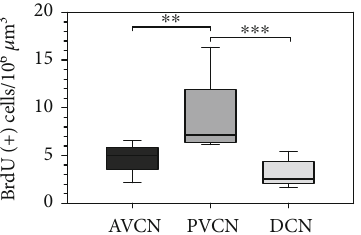
Figure 6: The whole-mount organ cultures of CN subnuclei showed a di ff erent mitotic capacity in the BrdU assay. A positive BrdU staining of individual cells was demonstrated in all examined preparations. The AVCN had an average of 4 : 7 ± 1 : 5 BrdU (+) cells/10 6 μ m 3 . The PVCN had with 9 ± 3 : 9 BrdU (+) cells signi fi cantly the highest mitotic activity ( mean ± SD ); the DCN contained 3 : 1 ± 1 : 4 BrdU (+) cells/10 6 μ m 3 ( n = 9 ). Box plots demonstrate the median with the upper and lower quartiles, and whiskers mark the upper and lower maximum values; asterisks indicate the signi fi cance level: ∗ p < 0 : 05 , ∗∗ p < 0 : 005 , ∗∗∗ p < 0 : 001 , and ∗∗∗∗ p < 0 : 0001 .